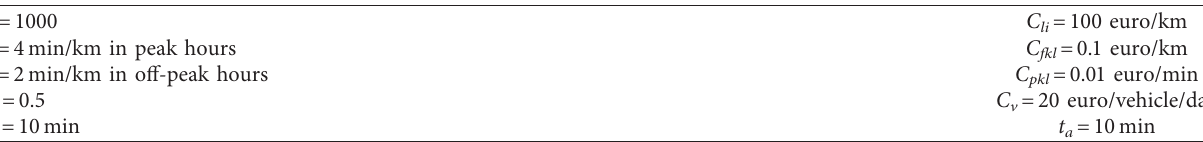
Figure 6: Network of Delft, the Netherlands. Table 3: Parameter values.